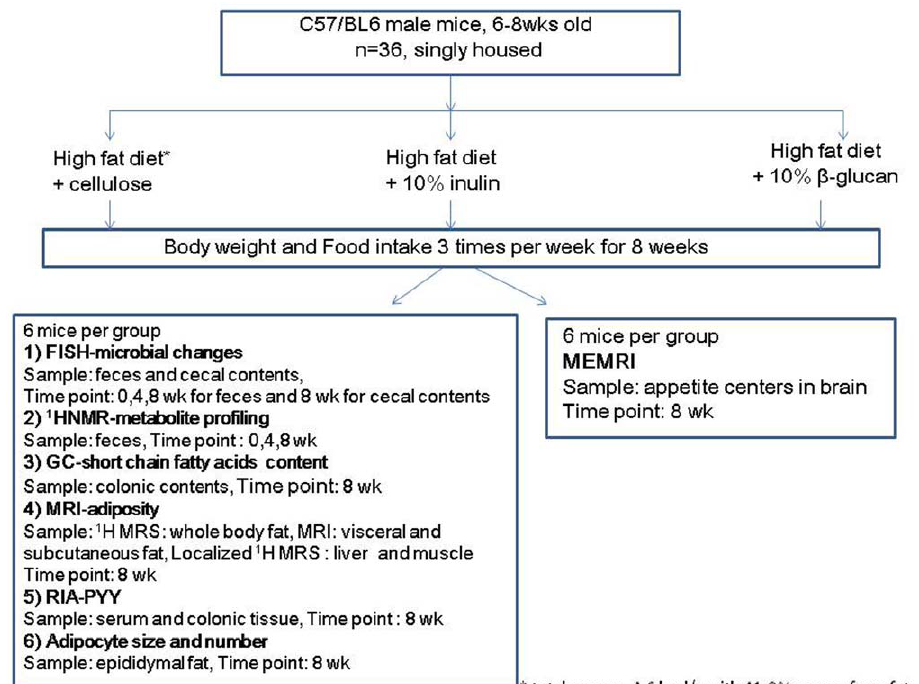
Figure 1. Flowchart showing the study design.